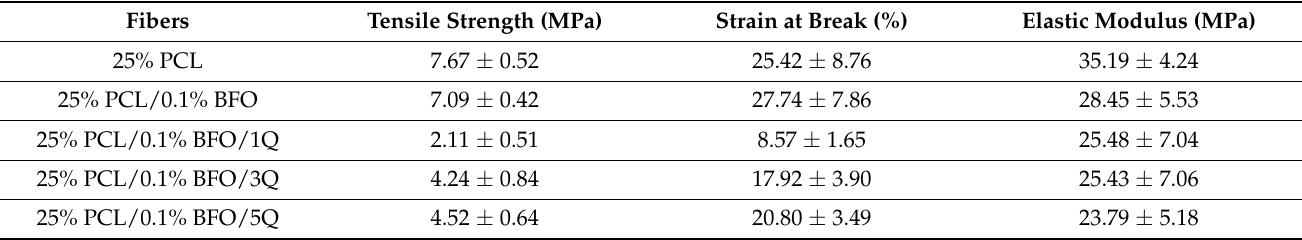
Table 1. The tensile strength (MPa), strain at break (%), and elastic modulus (MPa) values of each microfibrous